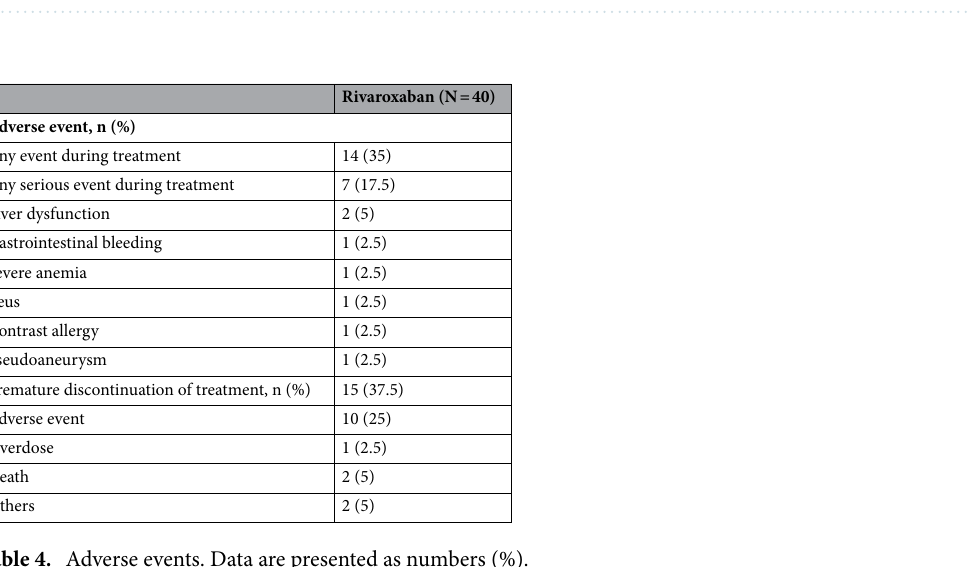
Table 3. Clinical efficacy and safety. Data are presented as numbers (%). DVT, deep vein thrombosis; PE, pulmonary thromboembolism; VTE, venous thromboembolism.